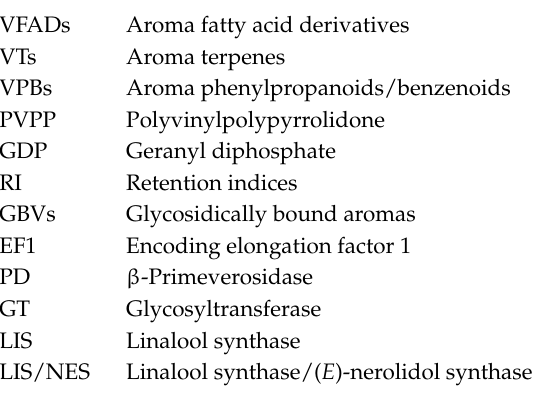
Supplementary Materials: The following are available online, Figure S1: GC-MS TIC chromatograms of endogenous free aroma compounds in normal green and albino-induced yellow tea leaves collected in April, August, and December, respectively; Table S1: Identified aroma compounds in the